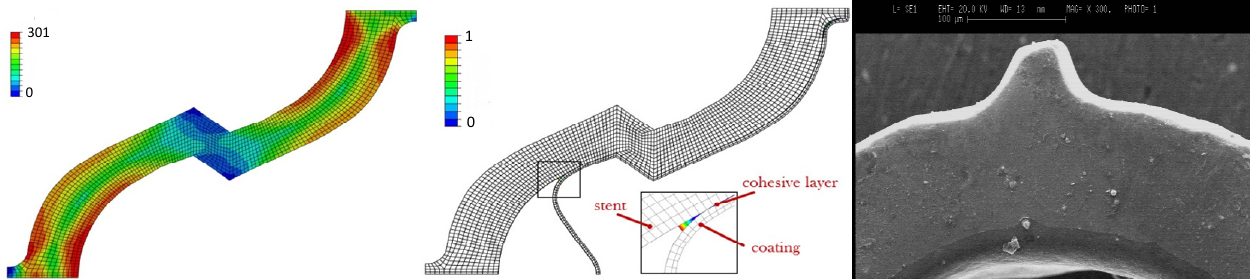
Figure 11: Numerical and experimental results of the expansion of the coated OPT stent design. Left: Von Mises stress distribution of the stent strut in MPa. Center: scalar damage variable D c of the cohesive layer. Right: damaged coating after stent-like 2D specimen